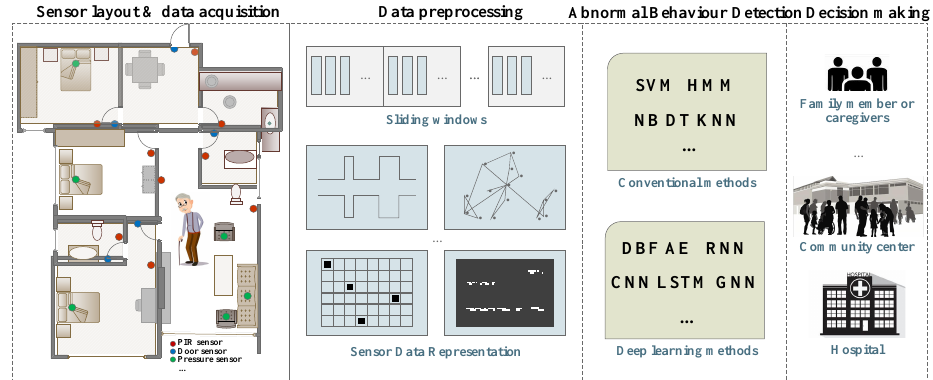
Figure 2. Abnormal behaviour detection in an ambient sensor-based SE.